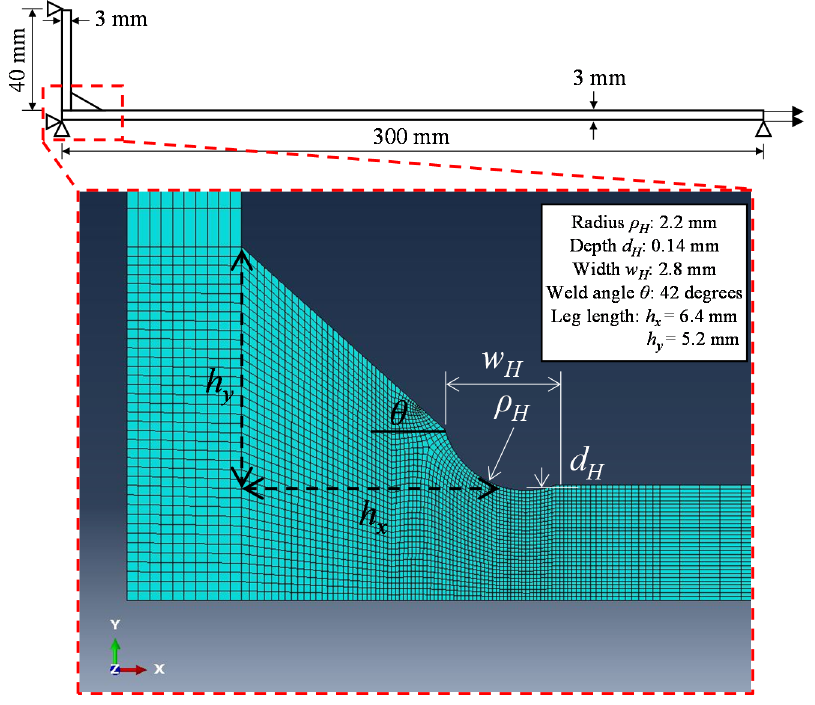
Figure 9. The global and local geometry for HFMI-treated detail. Table 4. Voce-Chaboche’s (VC) parameters for high-strength steels of S690 grade presented by Garcia, data from ref.